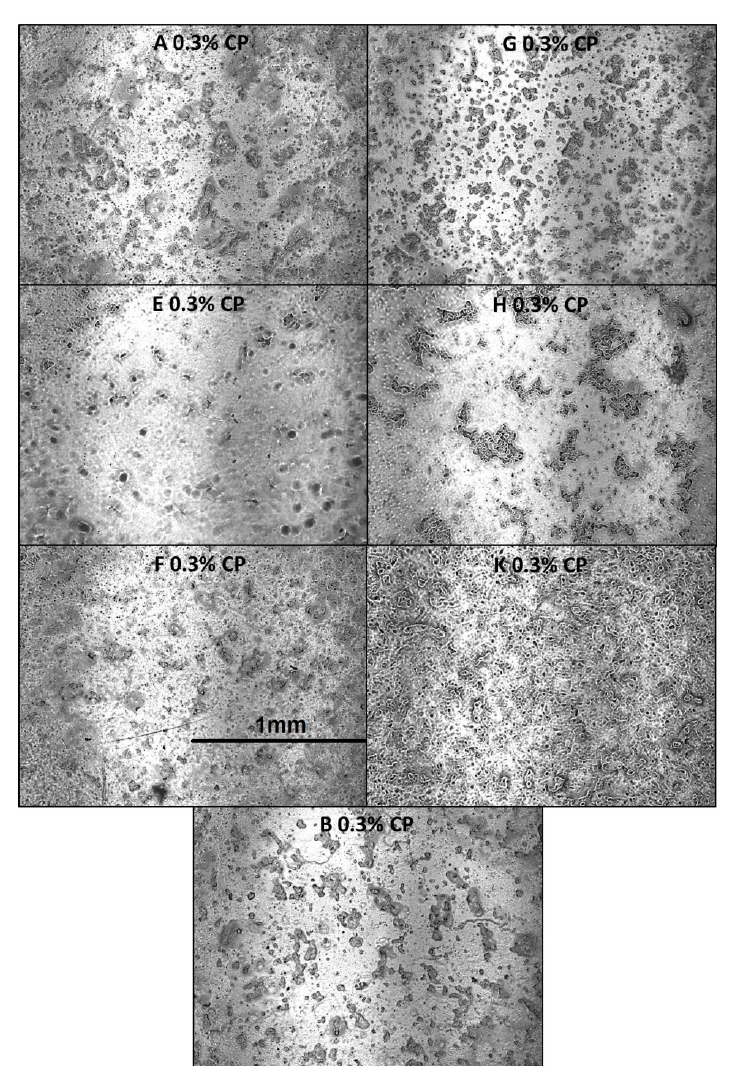
Figure 4. Micrographs of film Formulations A through K containing 0.3 wt% CP, captured at ~60% RH with 4×